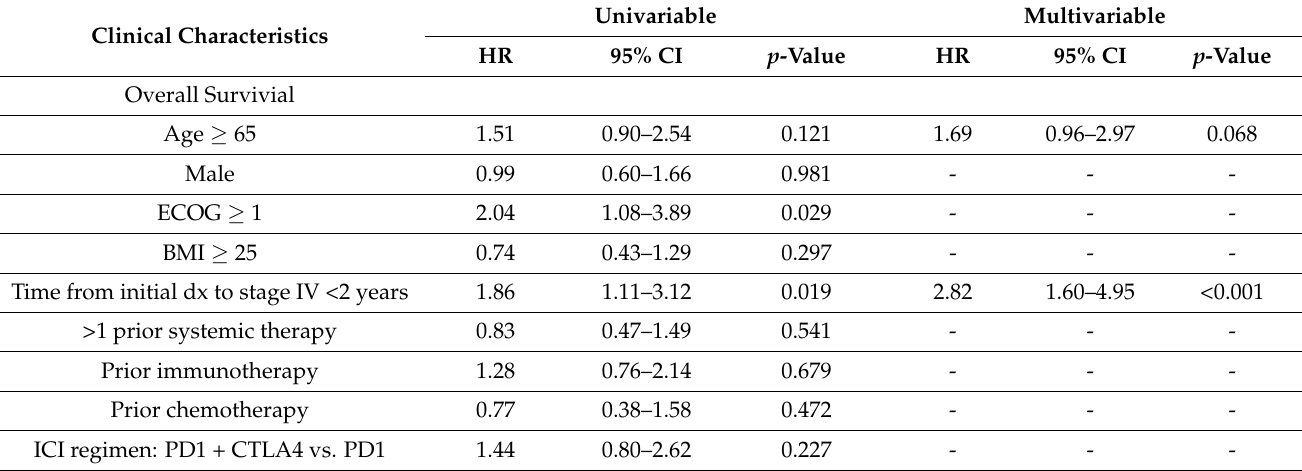
Table 3. Clinical variables associated with overall survival ( n =